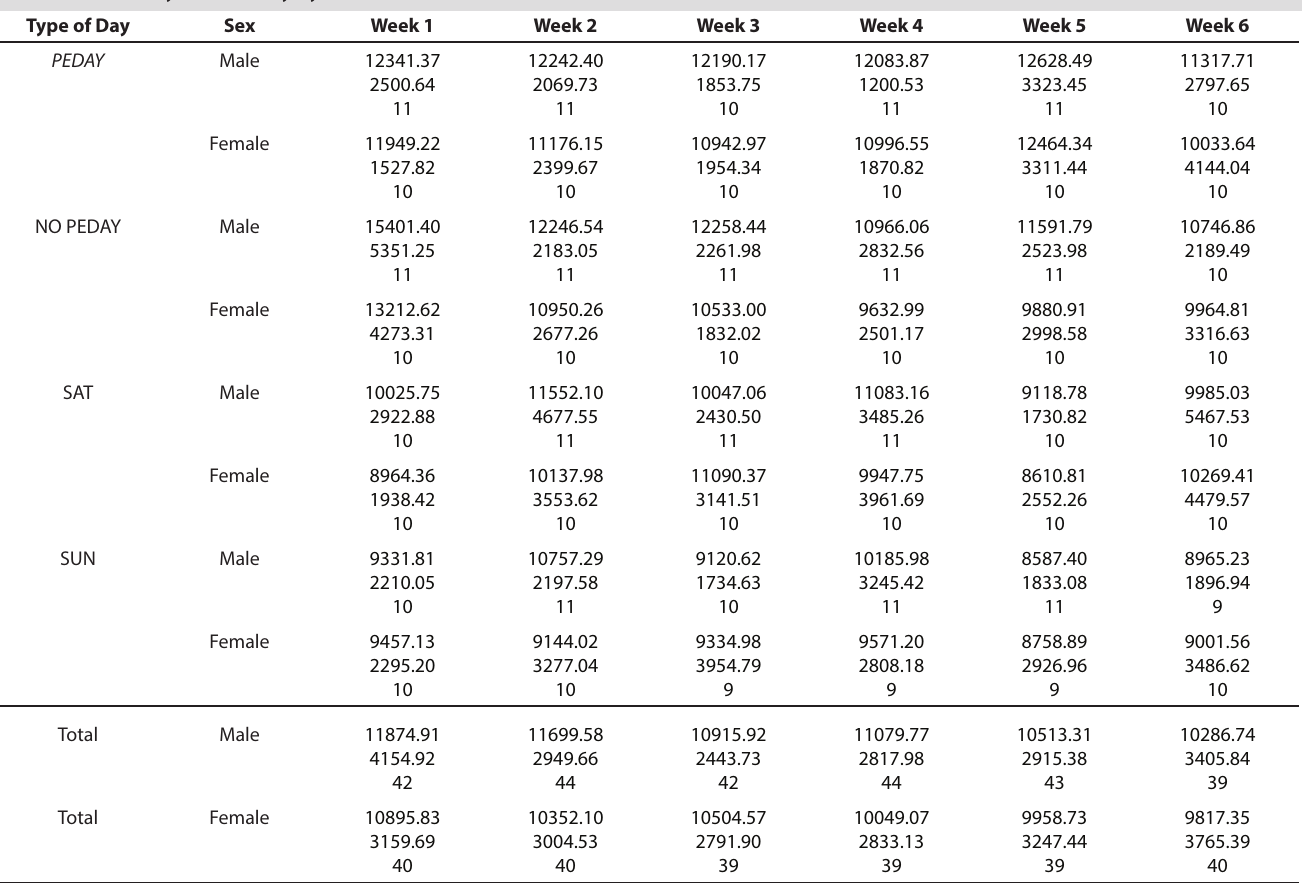
TABLE 2 Total Physical Activity by Sex Type of